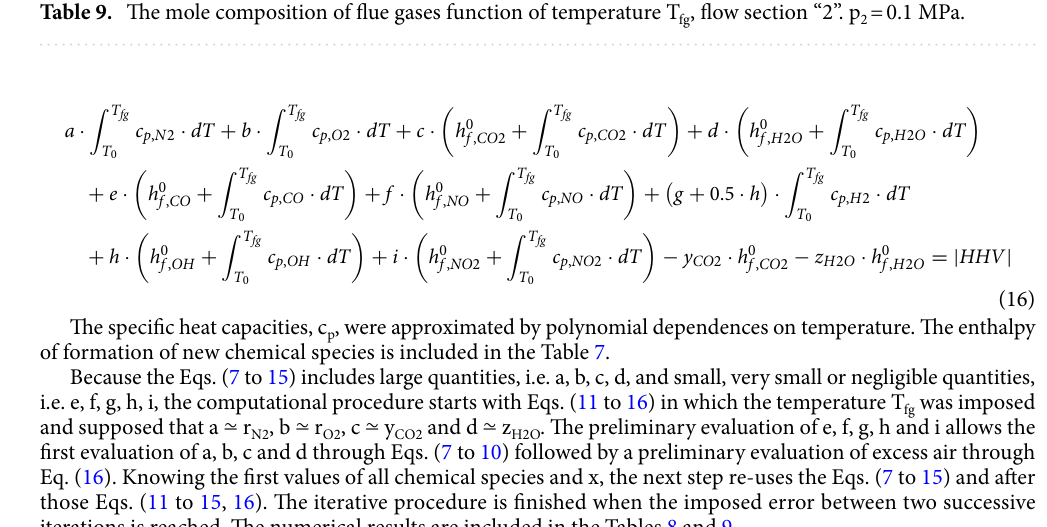
Table 9. The mole composition of flue gases function of temperature T fg , flow section “2”. p 2 = 0.1 MPa.